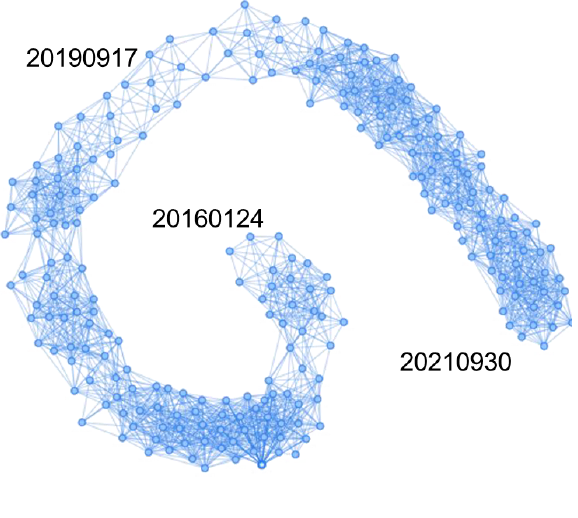
Figure 5 . Image and interferogram network.